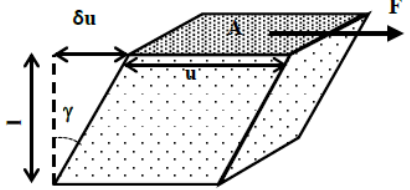
Figure 1: Body deformation by simple shear. Modified from [3].